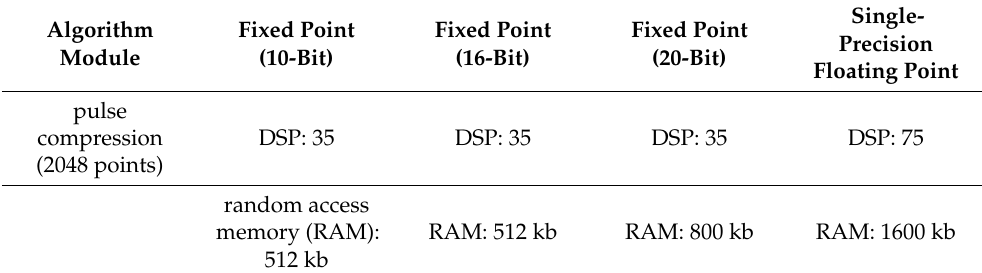
Table 2. Impact of bit width on processing resources.